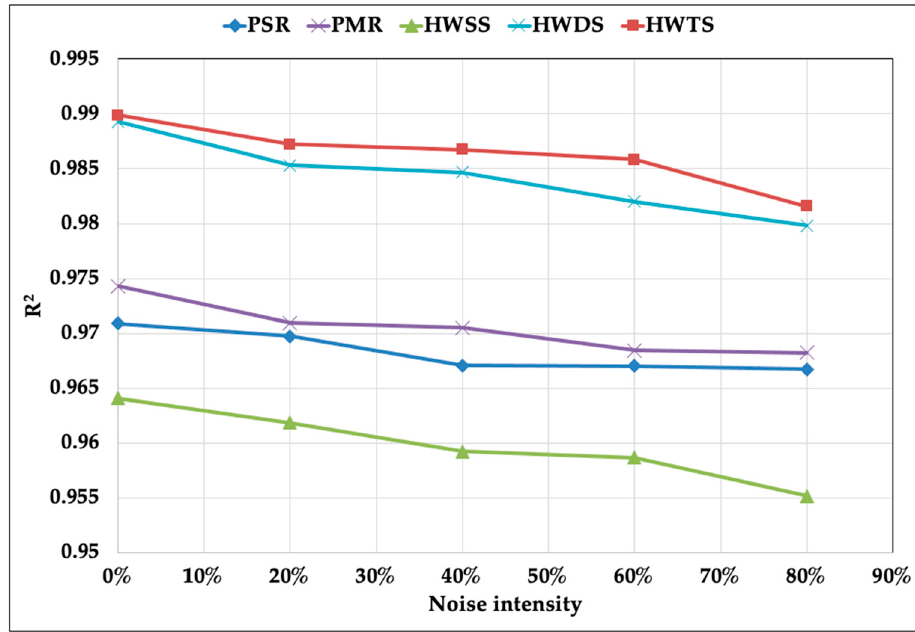
Figure 5. Variations of the coefficient of determination at different noise intensities for the five models.